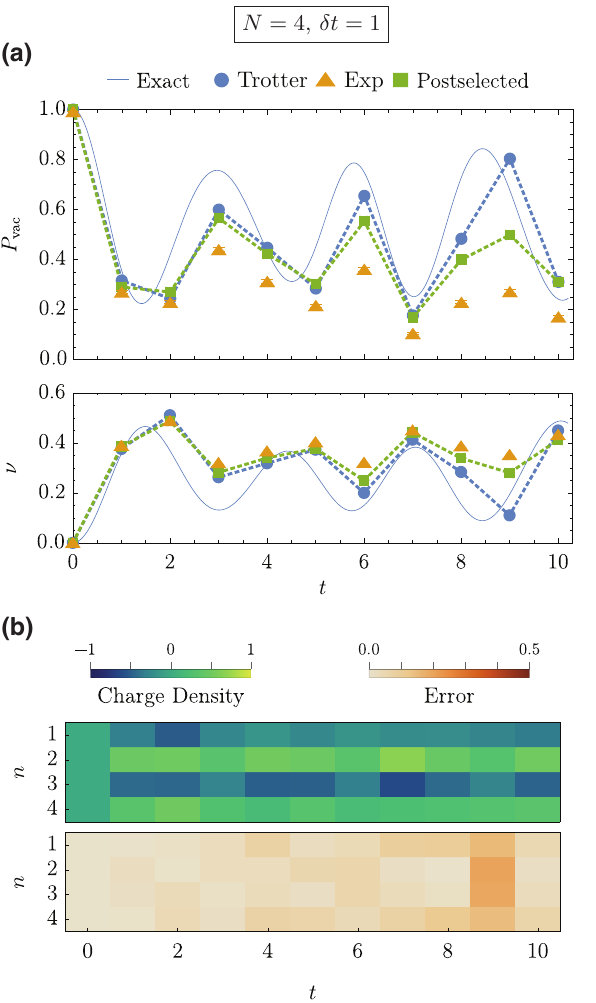
FIG. 7. Experimental results for N = 4 and δ t = 1. (a) The upper plot shows fluctuation in the bare-vacuum population, P vac ( t ) , while the lower plot shows the particle-number density, ν( t ) . (b) The upper plot shows the local charge density Q measured in the experiment after postselection, while the lower plot shows its deviation from theory.